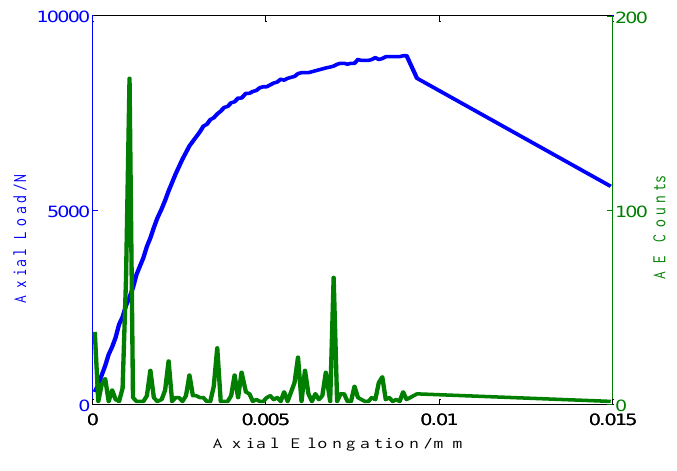
Figure 4. AE counts and axial elongation curve.